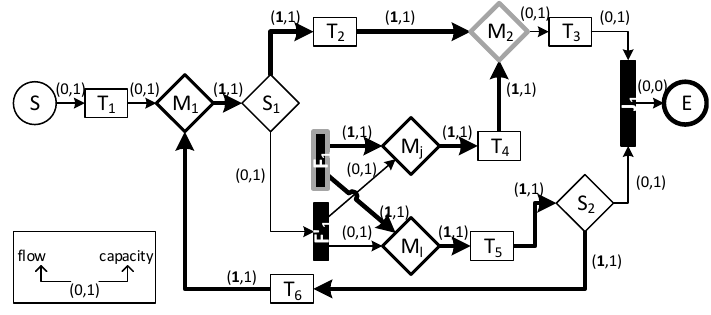
Figure 18. The flow network of our example workflow graph concerning the fork node F intersection ( M